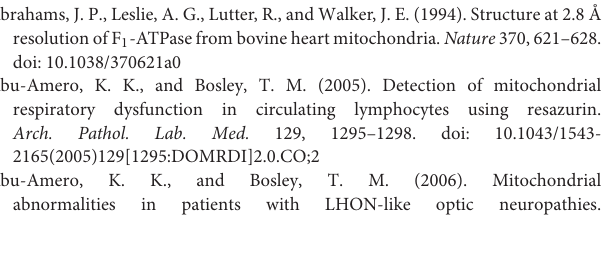
FIGURE 4 | hydrophobic, negatively and positively charged, uncharged polar, proline and special residues, respectively. The mutations are labeled according to their positions in human subunit a listed in Table 2 . The arrows indicate the path of protons in ATP synthesis direction. The conserved arginine ( h.s. a R159, S.c. a R186) on helix a H5 is indicated by stick model; its orientation is randomly chosen. The figure was drawn with UCSF ChimeraX (Goddard et al., 2017).